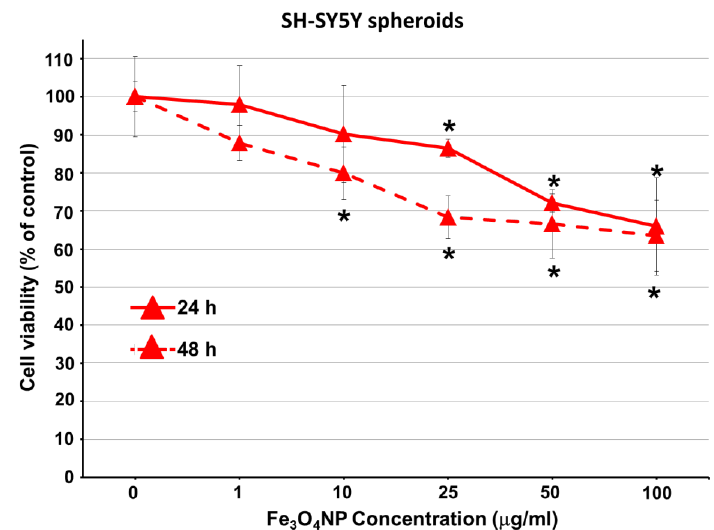
Figure 3. Cell viability evaluation in neuronal spheroids after short-term exposure to Fe 3 O 4 NPs. Effect on cell viability evaluated by Trypan blue test in SH-SY5Y spheroids exposed to different concentrations of Fe 3 O 4 NPs (1–100 μg/mL) after 24 and 48 h. Data are expressed as percentage of viable cells in treated cultures taking as 100% the number of viable cells in control condition and represent the mean ± S.D. * p < 0.05, statistical analysis by two-way ANOVA followed by Dunnett’s test.